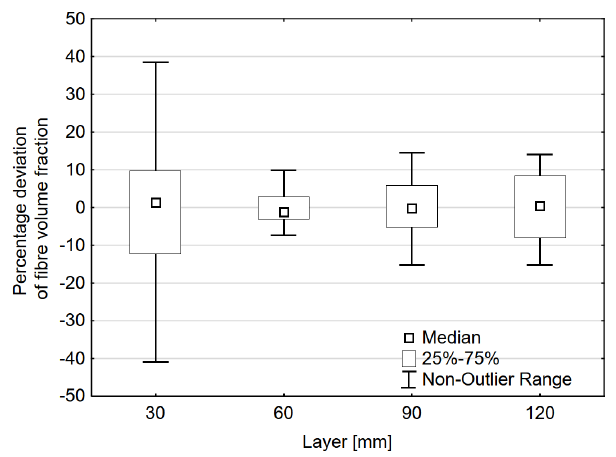
Figure 5. Percentage deviation of fibre volume.